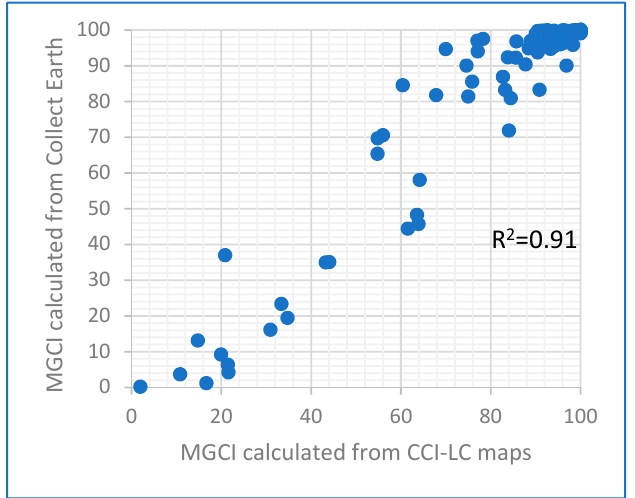
Figure 5. Scatterplot of MGCI estimates calculated for countries using CCI-LC and Collect Earth in 2017, showing that the two datasets are highly correlated.